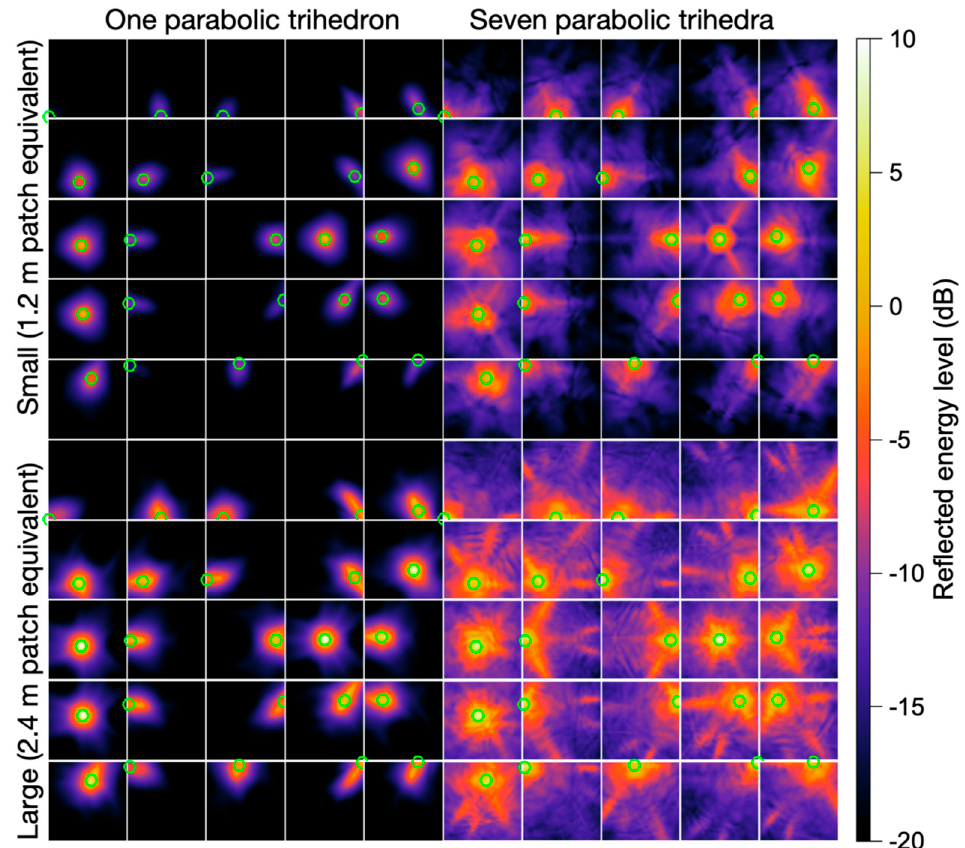
Figure 16. Spatial distribution of reflected energy level over a 2.4 × 2.4 m square for 25 source positions 2 m from reflectors composed of parabolic trihedra (details in the text). Source locations are indicated by the green circles. Values are speech-A-weighted.